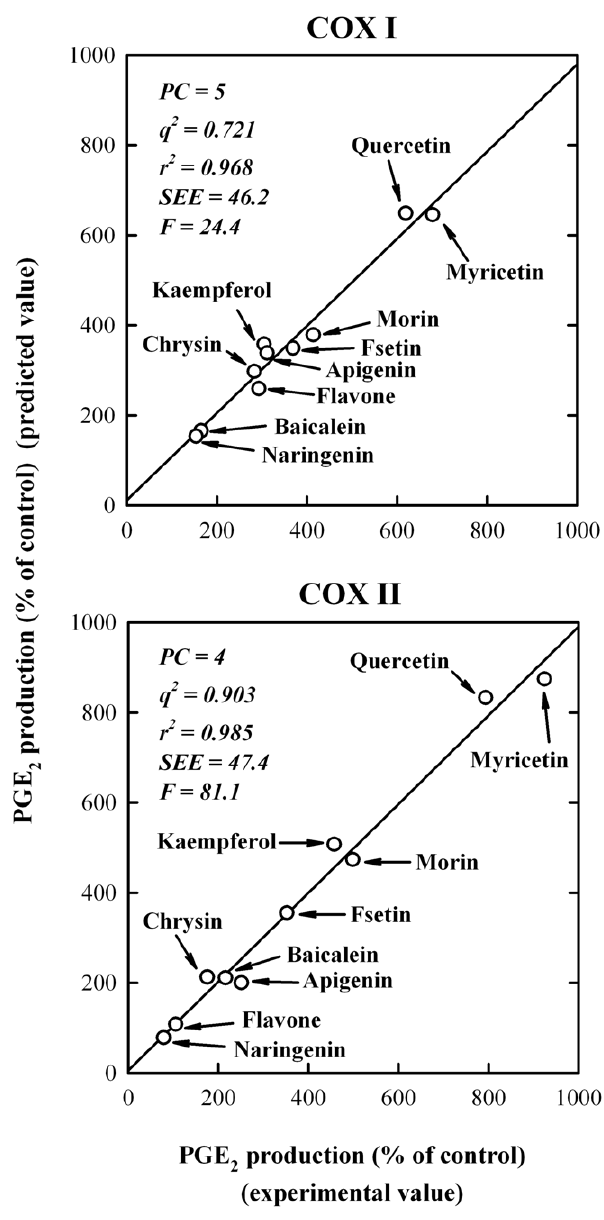
Figure 2. The 3-D QSAR/CoMFA analysis showing the correla- tion between the experimentally-determined COX-stimulating activity values and the predicted values. Nine representative bioflavonoids plus flavone were used in the analysis. The experimental values were based on measuring PGE 2 production, which was determined in our previous study [15]. Statistical parameters ( q 2 , r 2 , PC, SEE, and F) for the CoMFA models of COX I and II are also listed in the